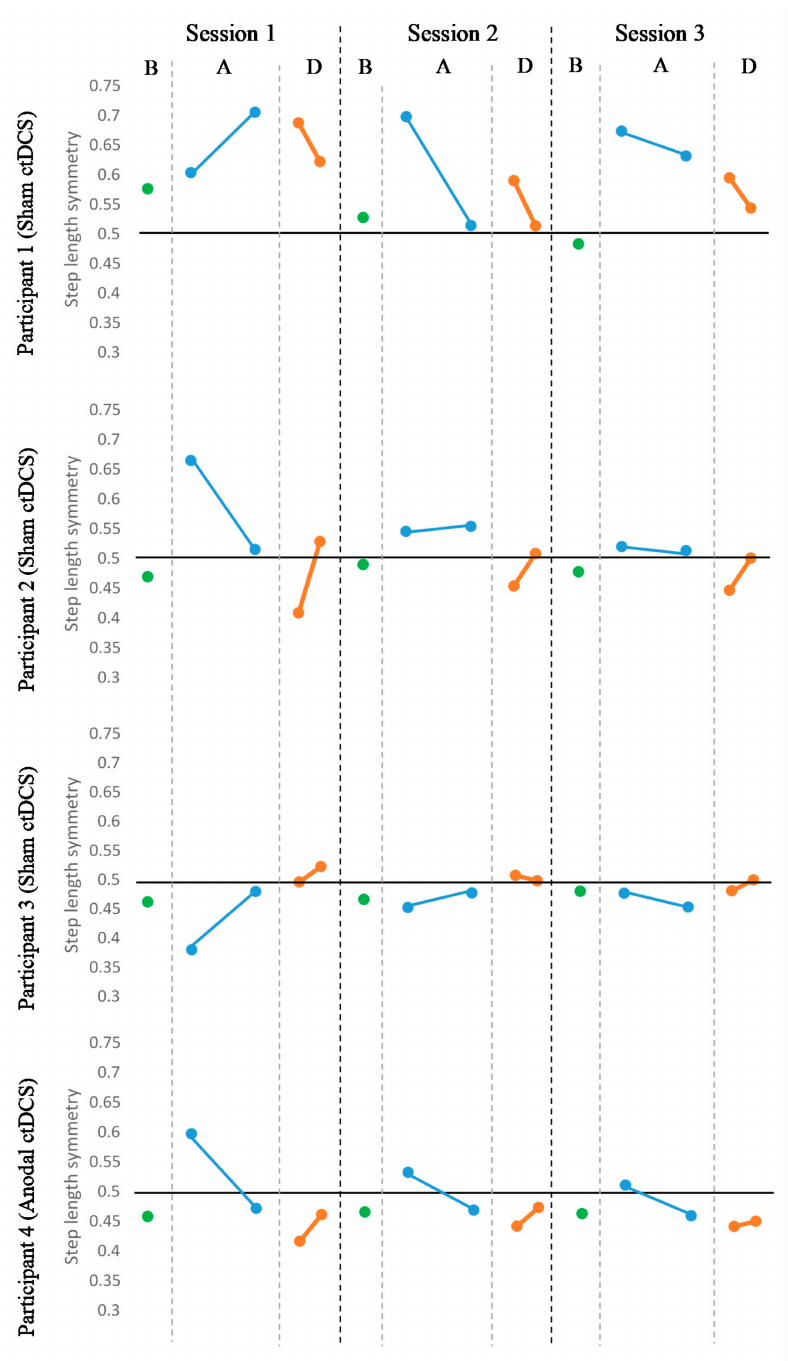
Figure 4. Treadmill step length symmetry over three consecutive sessions. The black horizontal line represents perfect symmetry. B: mean step length symmetry at the baseline phase (green), A: mean step length symmetry of first five and last five strides of the adaptation phase (blue), D: mean step length symmetry of first five and last five strides of the de-adaptation phase